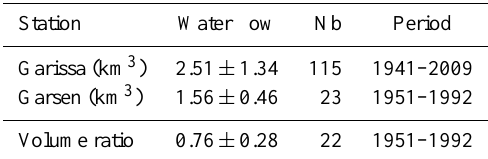
Table 1. Mean water flow per season (and 1 standard deviation) at each station and the resulting water volume ratio between the stations. The number of seasons (Nb) used and the periods consid- ered for each calculation are specified. Each year was divided into two hydrological seasons (1 March–31 August and 1 September– 29 February) to better use the available data. Seasons with more than 20% of missing data were excluded (10 seasons for Garissa for 1941–2009; 60 for Garsen for 1951–1998). The remaining missing data, 2.3% (542 days) and 6.0% (397 days) for Garissa and Garsen, respectively, were filled in by linear